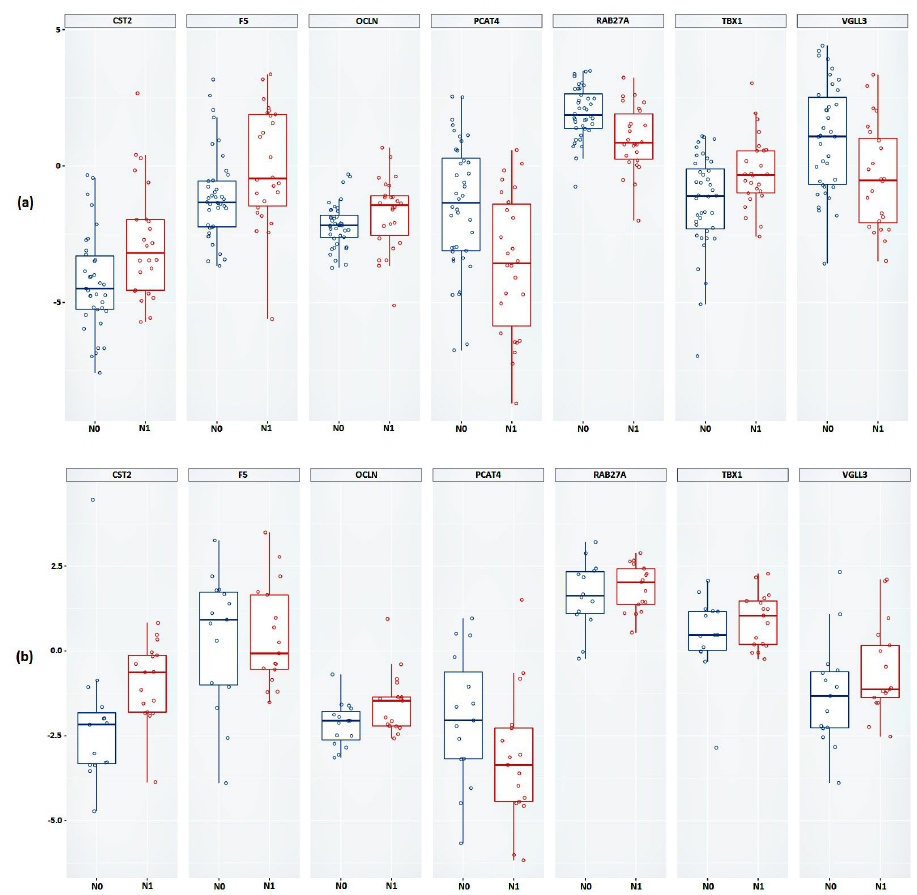
Figure 3. Box plot of the relative mRNA expression levels (in log scale) of CST2 , F5 , OCLN , PCAT4 , RAB27A , TBX1 , and VGLL3 genes between N0 and N1 groups in ( a ) FFT samples, ( b ) FFPE samples. Group N0 is marked in blue, group N1 is marked in red.